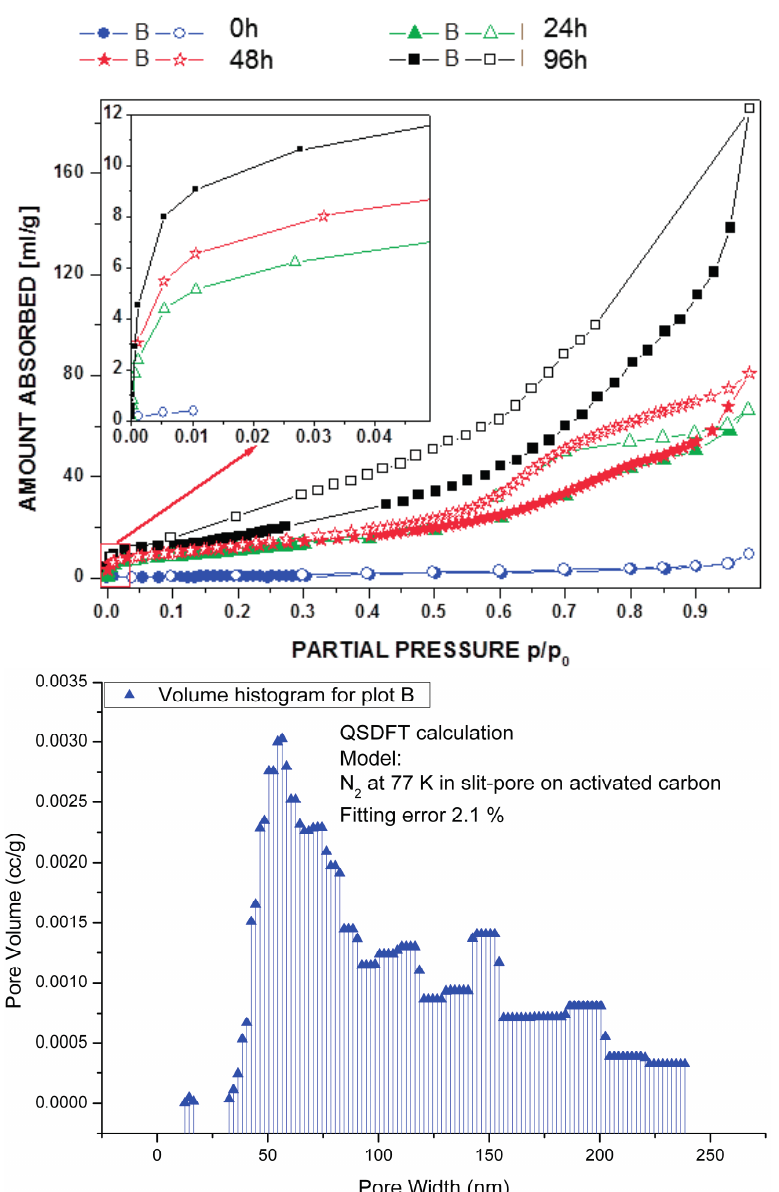
Figure 1. Adsorption isotherms (BET) for the adsorption (closed symbols) and desorption (open symbols) of N 2 (77 K) on 2 ∞ [Sm 2 Cl 6 (bipy) 3 ]·2bipy ( 5 ) for an activation of the MOF at 300 °C and 10 − 6 mbar for activation times between 0–96 h; prolonged activation times result in formation of meso- and macropores indicated by growing hysteresis ( top ); determination of the pore distribution of the thermally treated framework 5 after 96 h using QSDFT calculation based on slit-pore model for activated carbon ( bottom